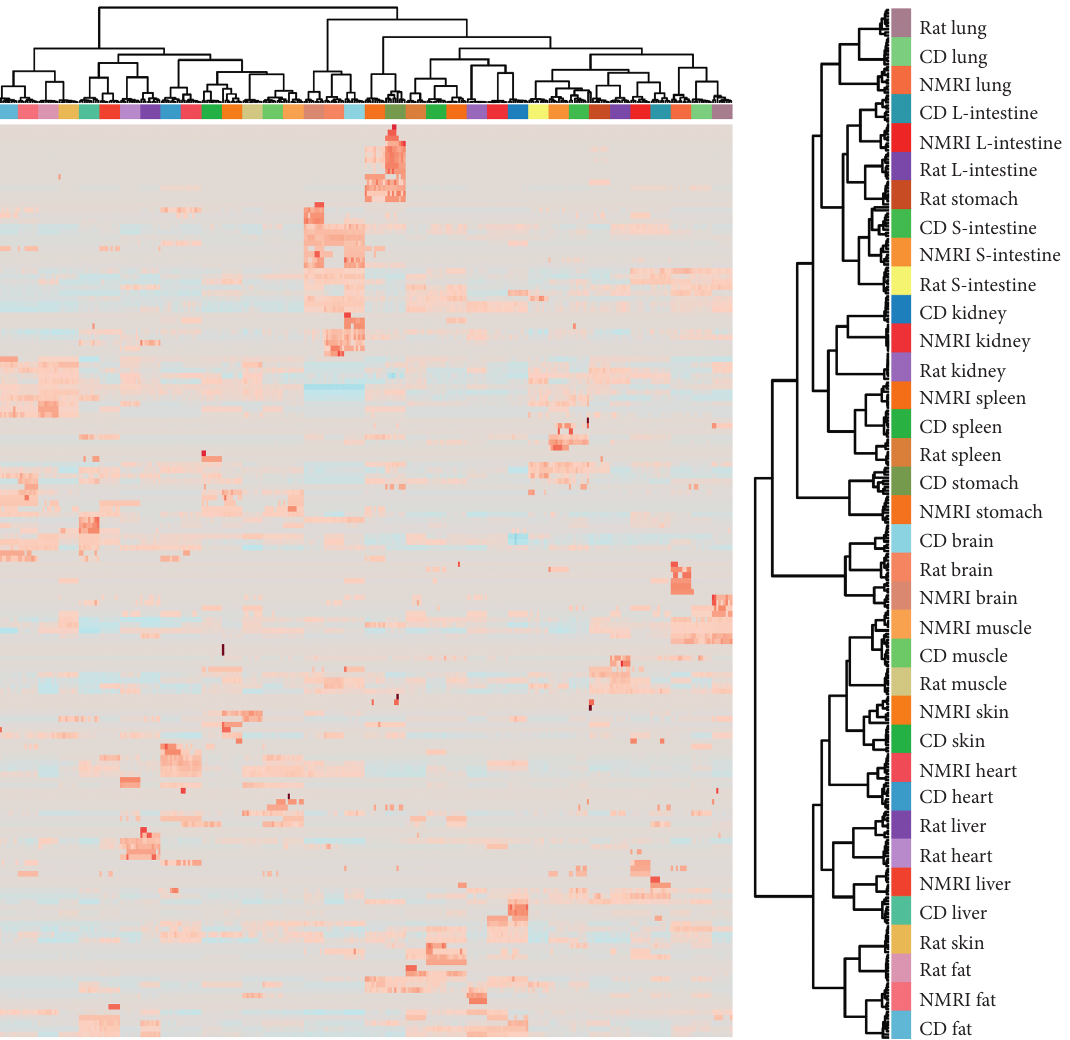
Figure 3: Heatmap clustering of fatty acid constituents in 12 organs/tissues of CD1 and NMRI mice and rats ( n � 9). Analysis was performed using MetaboAnalyst (http://www.metaboanalyst.ca). Distance measure of Elucidation and clustering algorithm of Ward were applied in the